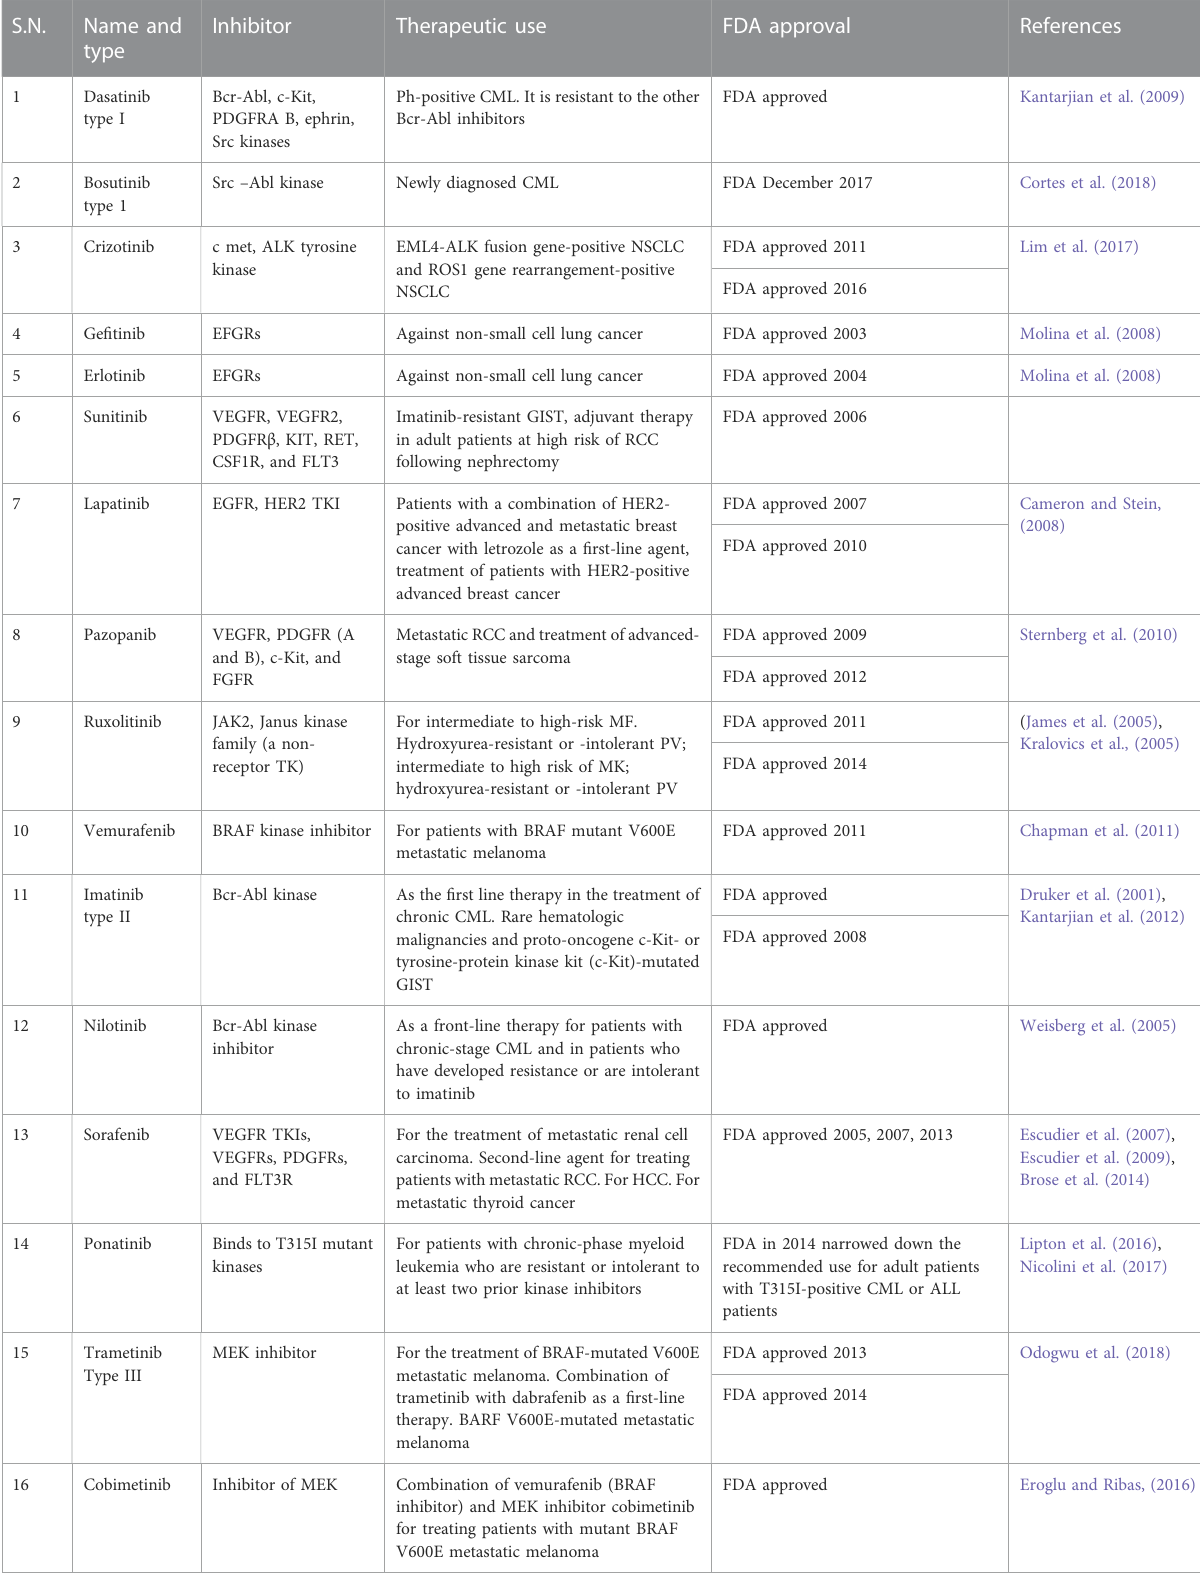
TABLE 2 Therapeutic uses of FDA-approved kinase inhibitors.